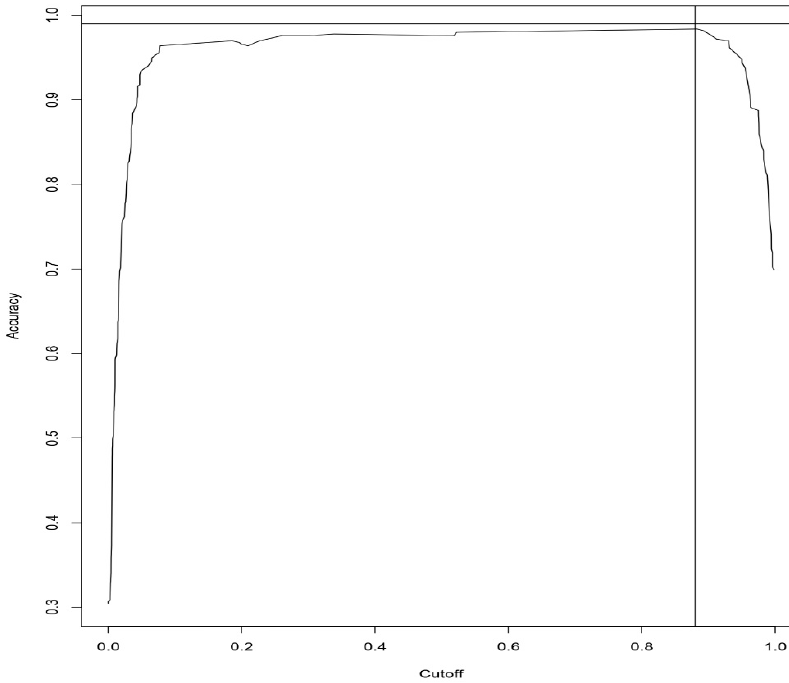
Figure 4. Accuracy Vs. cut-off curve for Logistic Regression Approach.